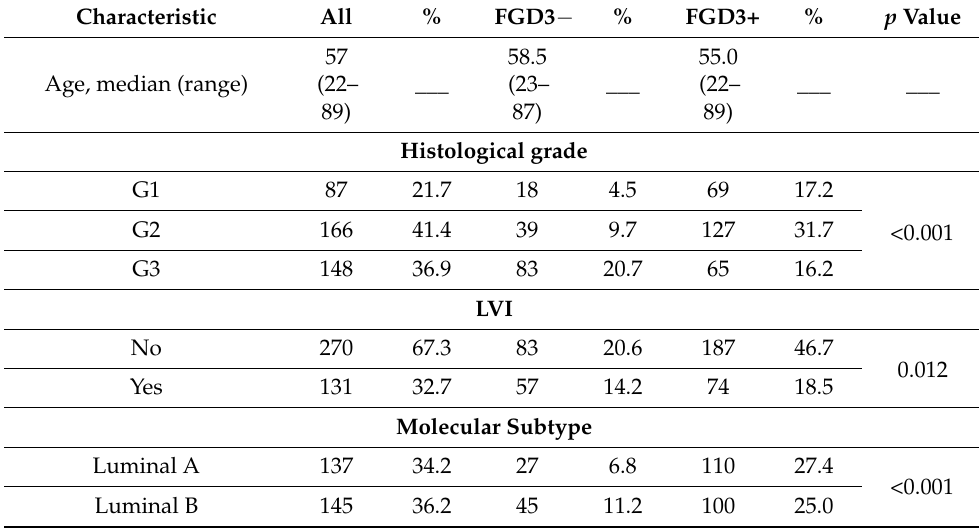
Table 1. Clinical and pathologic characteristics of patients: overall and according to FGD3 expression. Abbreviations: LVI lympho-vascular invasion; AJCC stage The American Joint Committee on Cancer staging of 2017; BCS breast conserving surgery; SLB sentinel lymph node biopsy; AD axillary lymph node dissection.